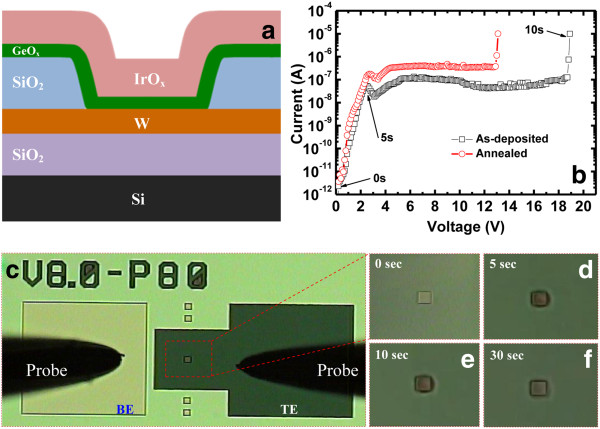
IrOx/GeOx/W MIM structure, typical I-V characteristics, and migration of oxygen ions. (a) Schematic diagram of the IrOx/GeOx/W MIM structure. (b) Typical I-V characteristics of as-deposited and PMA devices. (c to f) The migration of oxygen ions during application of a formation voltage, as shown in (b).